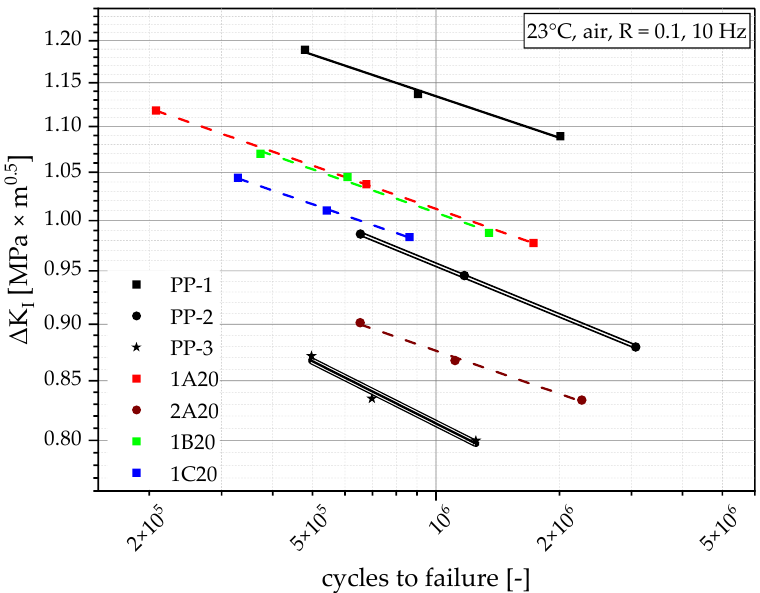
Figure 10. Graphical illustration of FCG resistance of the virgin blending partners PP-1 and PP-2, as well as the injection molding benchmark PP-3 and all compounds with 20 m% recyclate content. Initially applied ΔK I as a function of cycles to failure. All lines are linear approximations between three measurement points.